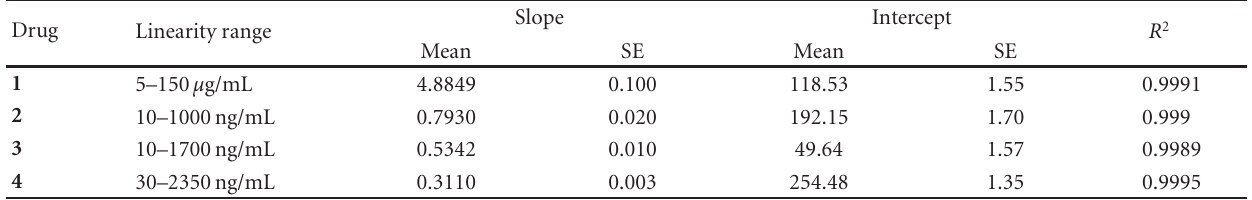
Table 3: Regression analysis parameters for the determination of 1–4 in spiked human plasma samples using the proposed method. Drug